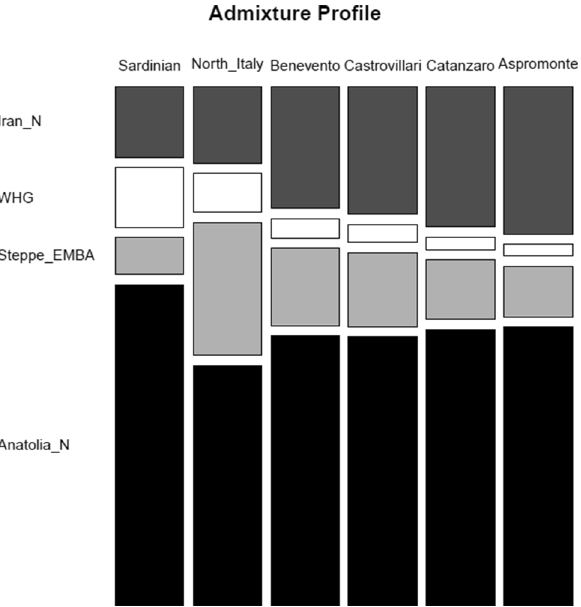
Figure 4. Mosaic plot of admixture ancestry profiles as inferred by qpAdm . Admixture profiles of Italian population groups included in the modern extended dataset have been tested using a four-population model including CHG/Iran_Neolithic, WHG, Steppe_EMBA and Anatolian_Neolithic as putative ancient source groups. Specific details about inferred ancestry proportions and relative levels of significance are reported in the Supplementary Table